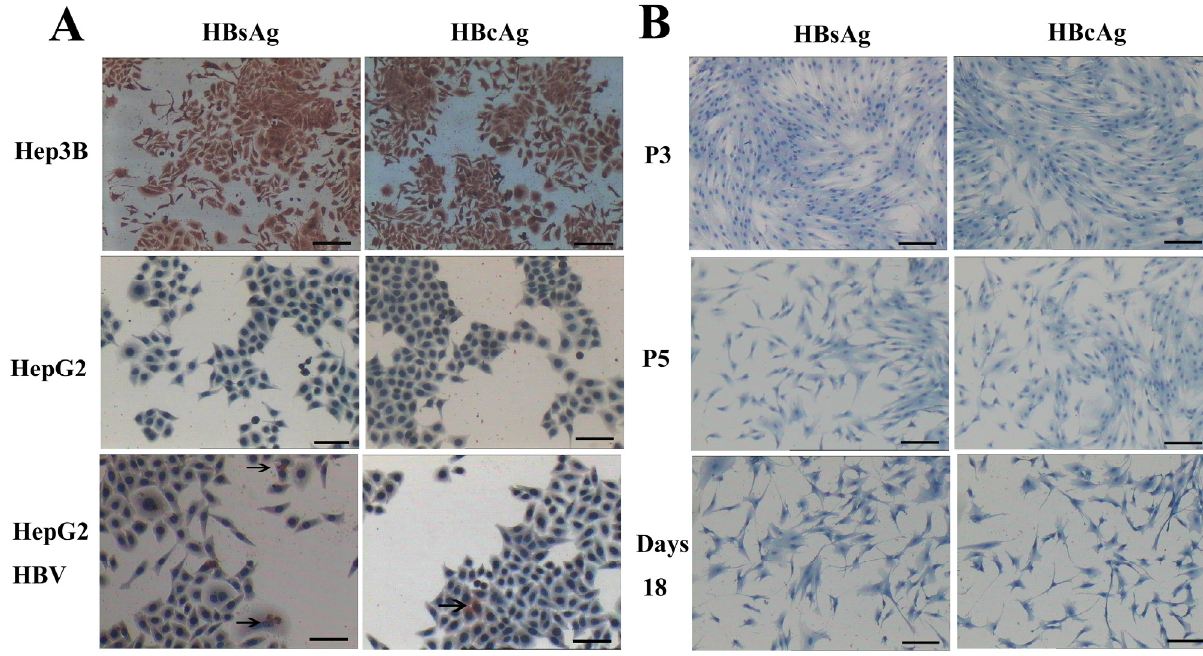
Figure 10. AD-MSCs and AD-MSC-derived hepatocytes are resistant to HBV infection. ( A ) HepG2 cells served as negative control. Hep3B cells were positive control. HepG2 cells infected with HBV (HepG2 HBV) for 48 h were positive for HBsAg and HBcAg; The arrows refer to HBsAg and HBcAg positive cells; and ( B ) The 3rd and 5th generation AD-MSCs (P3, P5) were negative for HBsAg and HBcAg. Induced AD-MSCs at day 18